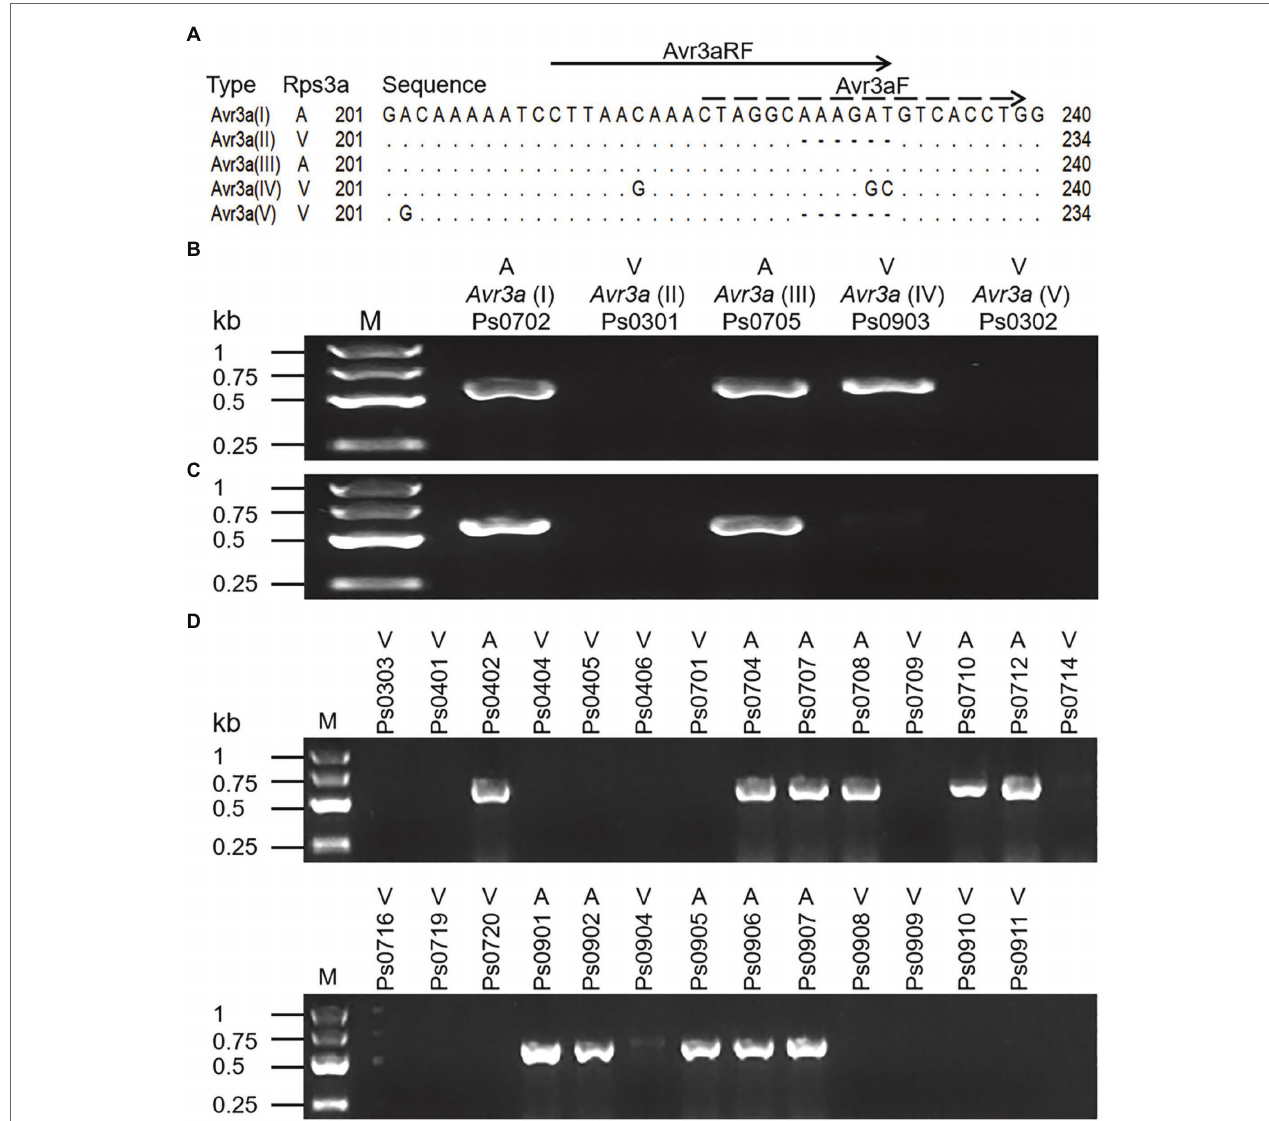
FIGURE 3 | The PCR assays for the avirulence alleles of Avr3a . (A) Positions of the allele-specific forward primers. The dotted line shows the position of the allele- specific forward primer (Avr3aF) which designed by Dussault-Benoit et al. (2020). The solid line shows the position of the redesigned forward primer (Avr3aRF). The shared reverse primer (Avr3aR) is a gene-specific prime. A indicates an avirulent isolate or allele and V indicates a virulent isolate or allele. (B) The PCR assay of five Avr3a alleles with Avr3aF/Avr3aR. (C) The PCR assay of five Avr3a alleles with Avr3aRF/Avr3aR. (D) The PCR assay of 27 P. sojae isolates with